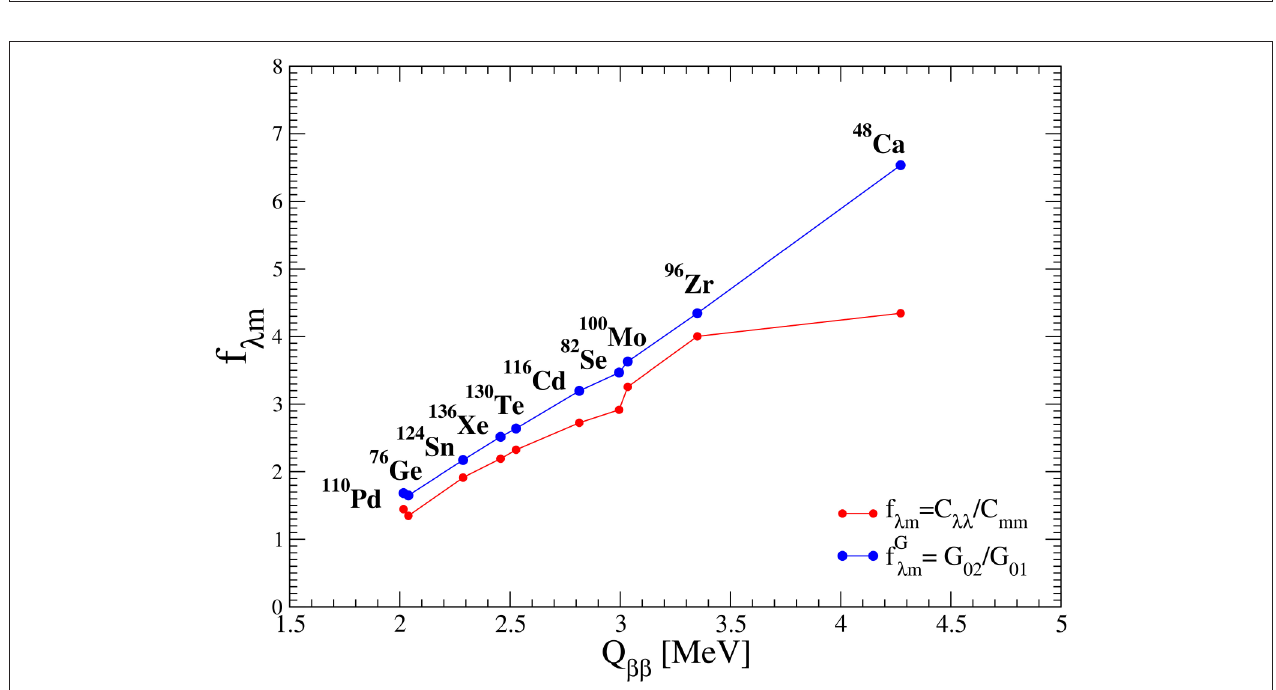
FIGURE 2 | The decomposition of coefficient C λλ (see Equation 11) on partial contributions C 0 k I associated with phase-space factors G 0 k (k nuclei of experimental interest. The partial contributions are identified by index k. The contributions from largest to the smallest are displayed in red, blue and black colors, respectively.